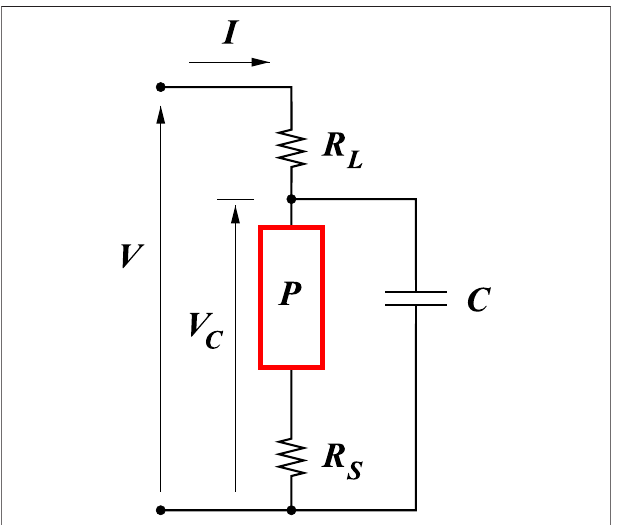
FIGURE1| Circuit embedding thePCM [33]. Parameters referred tothe PCM take suf fi x P in the equations and fi gures.